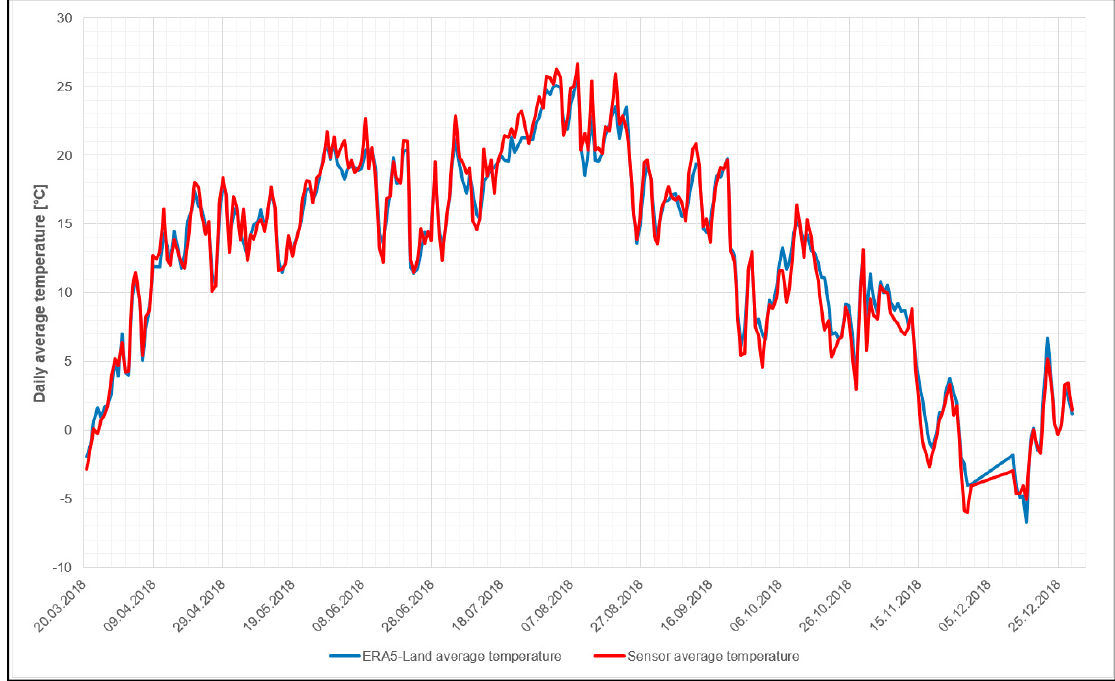
Figure 6. Graph of daily average temperatures calculated from ERA5-Land data (blue line), in-situ observations (red line). The Pearson correlation coefficient is equal to 0.99.